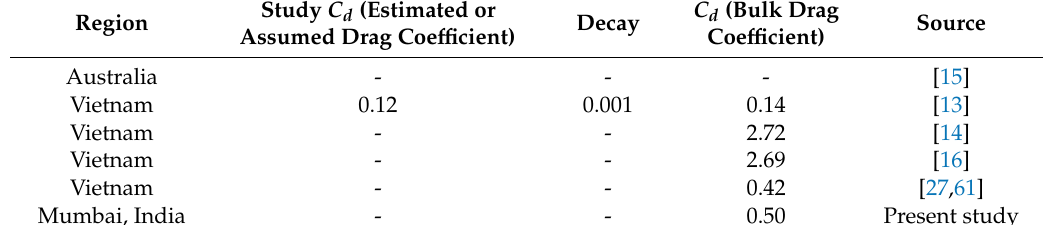
Table 1. Review of C d calculated for mangroves (Reproduced with permission from [21], esa, 2013). Region